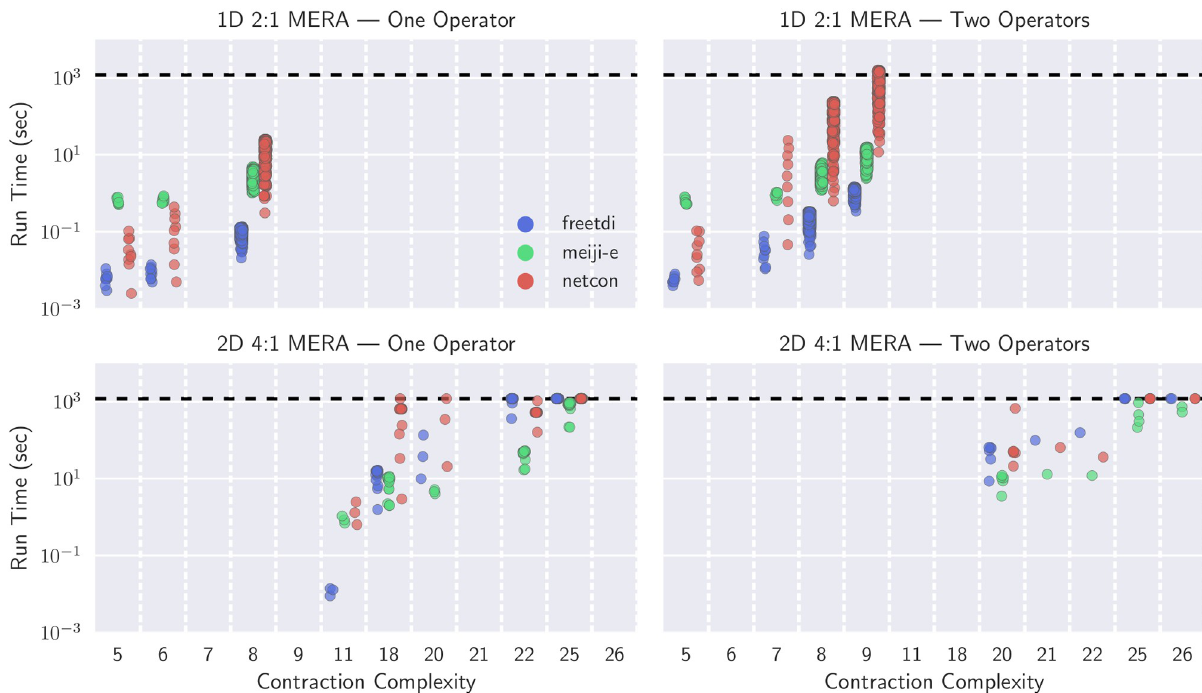
Fig 5. Run times for the three algorithms on select MERA networks, binned by optimal contraction complexity. All algorithms are timed out at 20 minutes (horizontal dashed line), and a network that remained unsolved by every algorithm is not included. 2D MERA with one operator had 48 of 131 networks that did not finish, and the two operator networks had 193 of 207 that did not